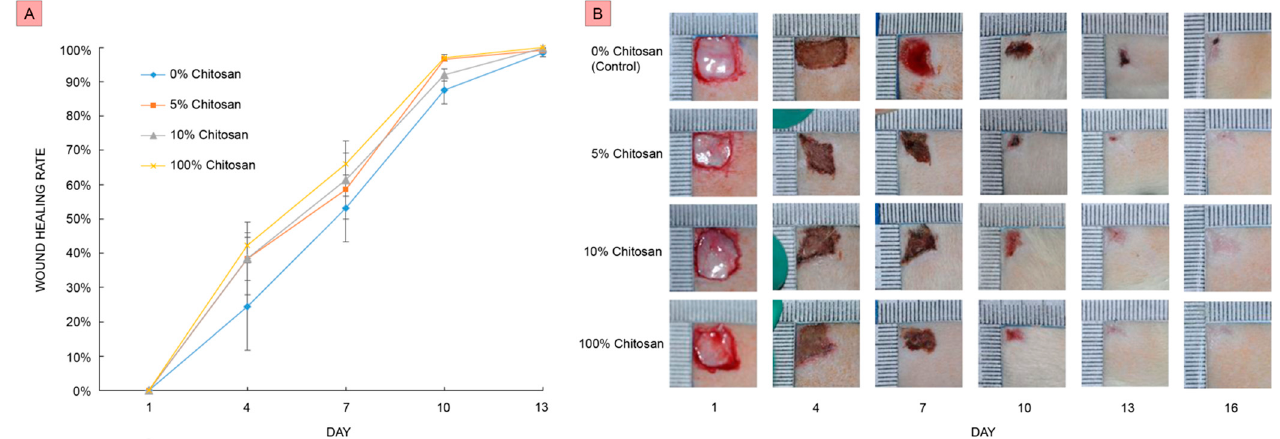
Figure 1. ( A ) Results of wound healing animal test displaying wound healing rates; ( B ) Photos of wounds in the wound healing test.